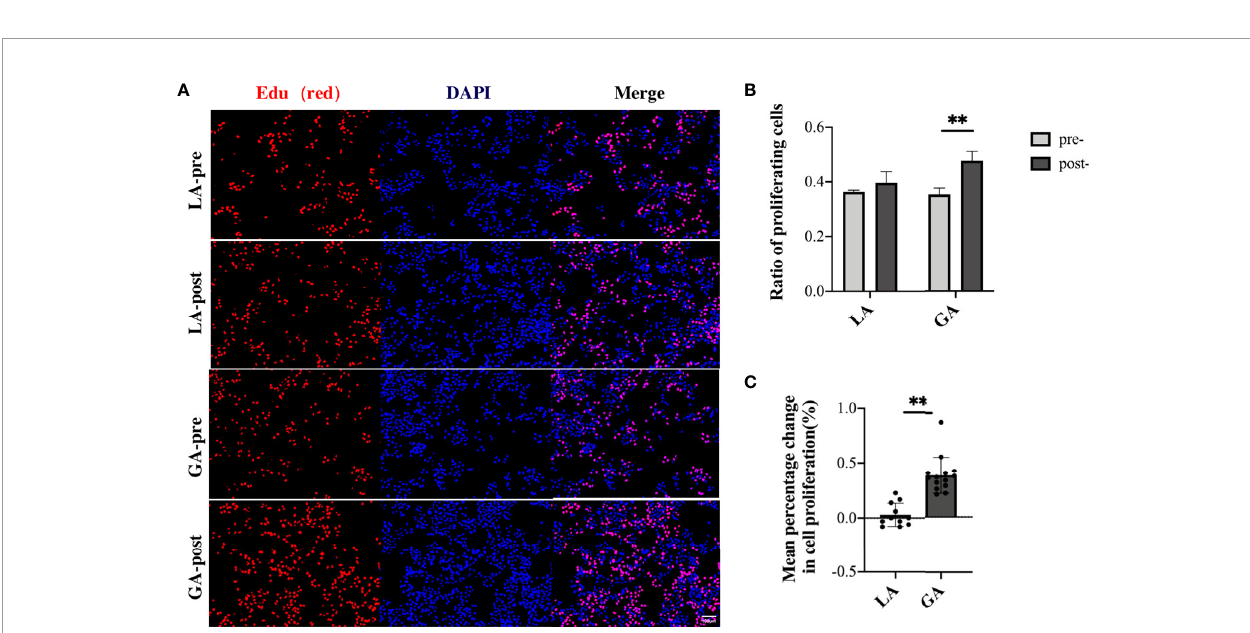
FIGURE 5 | Serum from RFA patients receiving GA facilitated cell proliferation of HepG2 cells after long-term exposure, demonstrated with EdU assays. (A) HepG2 cells cultured with preoperative and 1h postoperative serum from the LA and GA groups, respectively; proliferative cells were stained with EdU (red), and nuclei were counterstained with Hoechst 33342 (blue); Original magni fi cation, 100X; (B) Graphical representation of the proportions of EdU positive cells of the four groups; (C) Graphical representation of the mean percentage change from post- to preoperative values in EdU positive cells in the GA vs LA groups. Values are expressed as mean ± SD. n = 11, LA group. n = 14, GA group. ** P < 0.01. GA, General Anesthesia; LA, Local